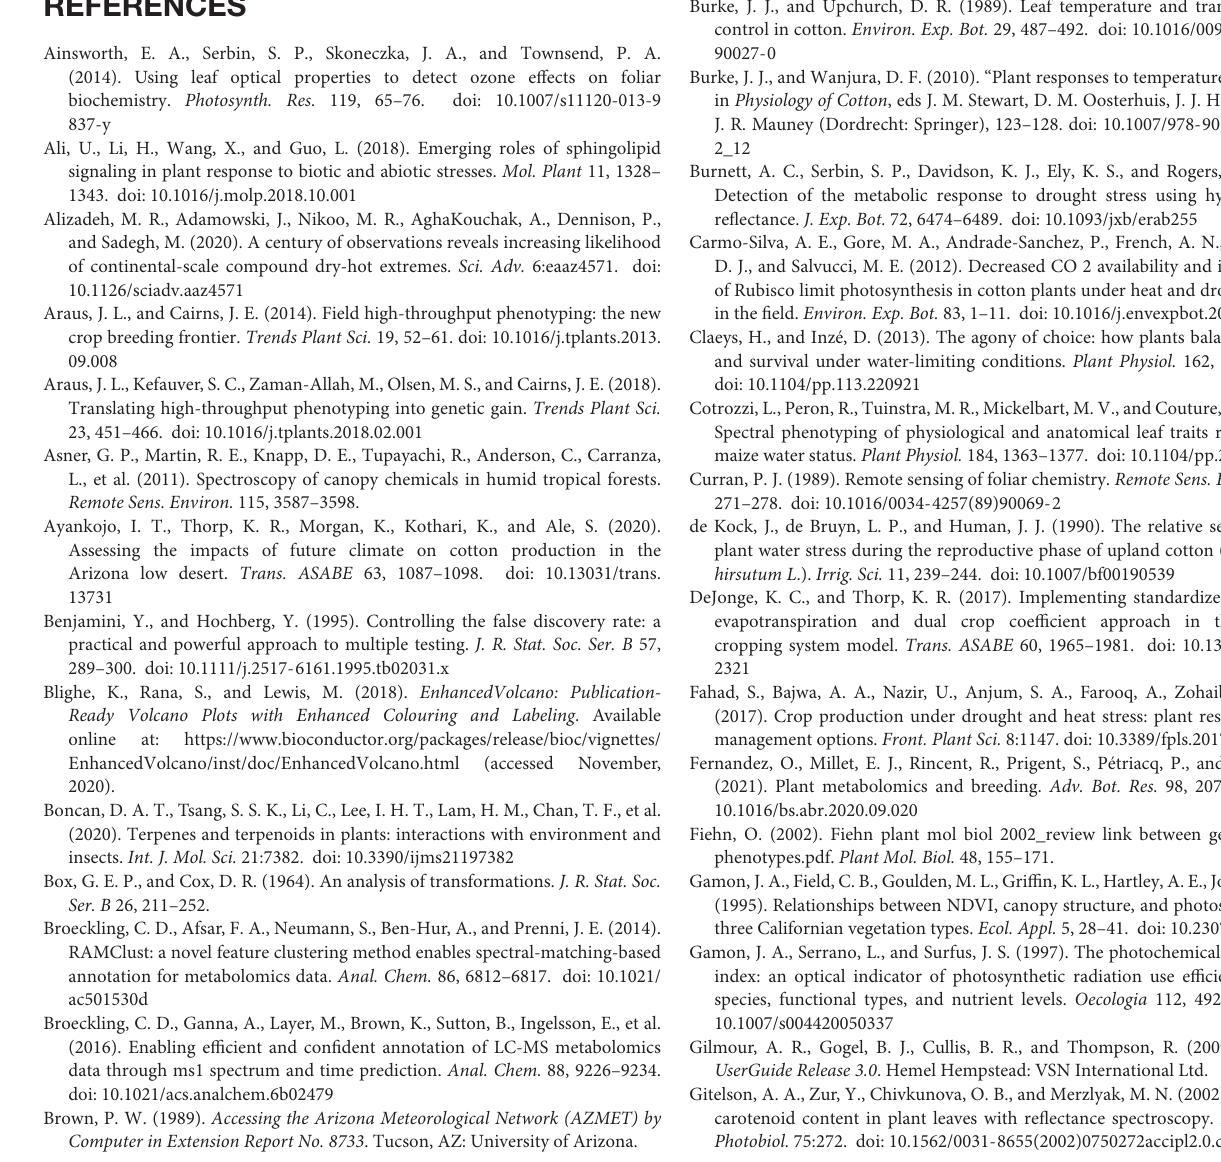
Supplementary Table 7 | Loading values of metabolites on principal component 1 and 2 for the 2018 leaf samples.